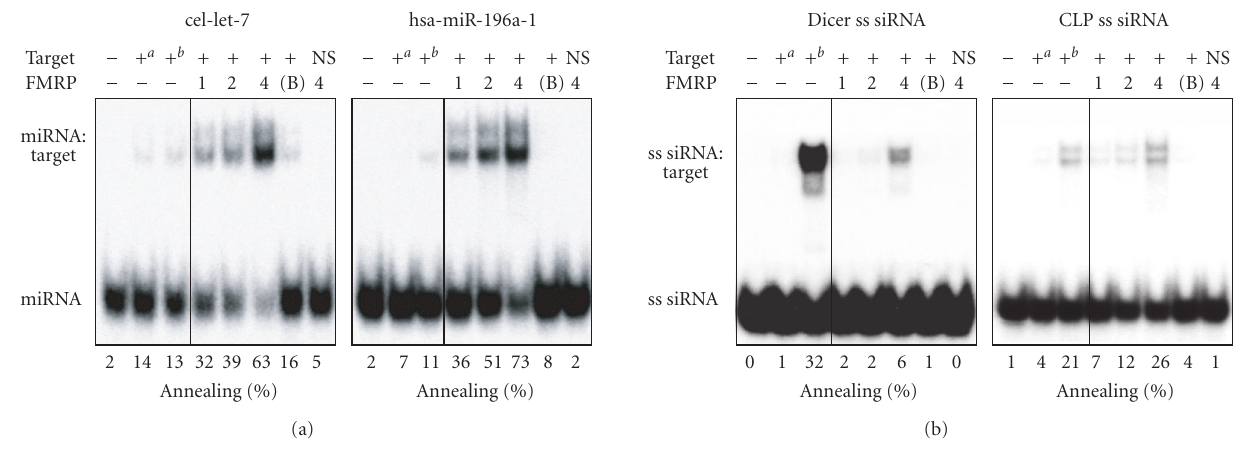
Figure 2: FMRP preferentially facilitates natural miRNA:target RNA complex formation. FMRP mediates miRNA (a) and siRNA (b) an- nealing to specific RNA targets. (a) 32 P-labeled cel-let-7 (left) or hsa-miR-196a-1 (right) was incubated with a specific lin-41 or HOXB8 RNA target, respectively, in the absence or presence of increasing amounts of FMRP, or BSA at 4 : 1 (protein:RNA) molar ratio. (b) The RNA strand annealing assays using a single 32 P-labeled strand of Dicer (left) or CLP (right) siRNA duplex incubated with a specific or nonspecific RNA target were performed as in (a). Control hybridization was conducted at 37 ◦ C for 10 min a or 65 ◦ C for 30 min b . RNA complexes were analyzed by nondenaturing 10% PAGE and autoradiography. B, BSA; NS, nonspecific